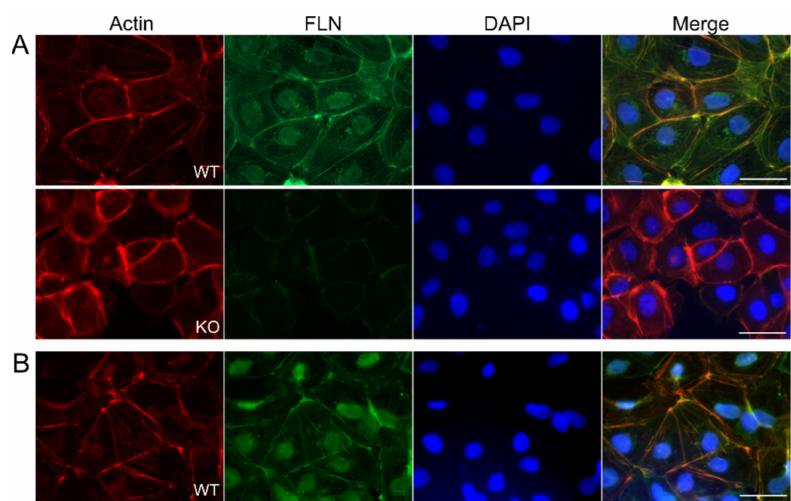
Figure 5. Fluorescence microscopy of TCam-2 wildtype (WT) and FLNA-deficient (KO) cells. ( A ) TCam-2 WT (WT) and FLNA-KO cells (KO) were stained with Atto 568-phalloidin for actin (red), immunolabeled for FLNA (green) using FLNA-specific and Alexa-488-labeled secondary antibodies and DAPI to visualize nuclei (blue). Merged images are shown on the right. ( B ) Immunofluorescence localization of FLNB (green) in TCam-2 WT cells. Scale bars: 50 µ m.